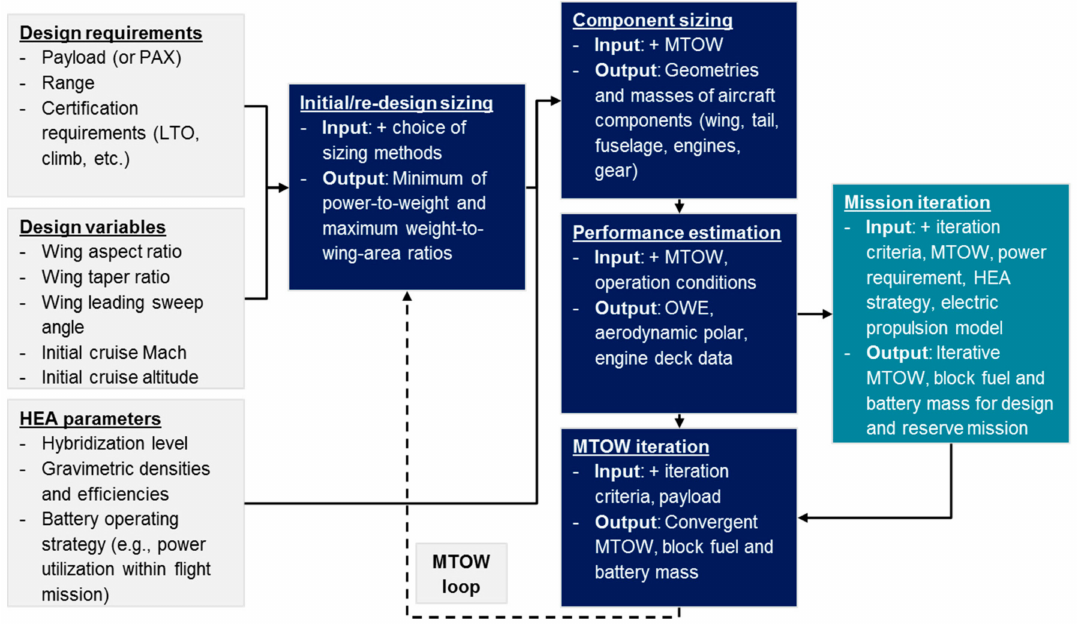
Figure 3. Flow diagram of the general approach for modeling